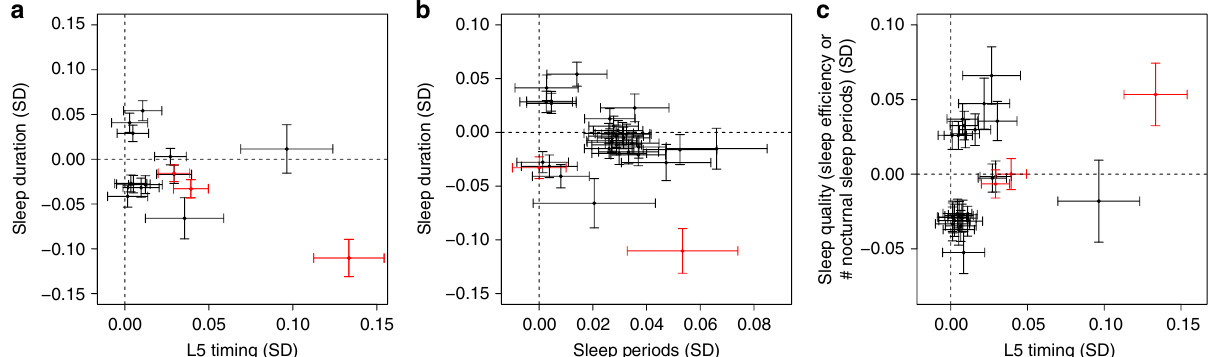
0.00 Fig. 2 Effects of restless legs syndrome-associated SNPs on derived sleep traits. Presented are the effect estimates for genetic variants associated with a either L5 timing or sleep duration, b either sleep duration or the number of nocturnal sleep episodes, and c either L5 timing or sleep quality (number of nocturnal sleep episodes or sleep ef fi ciency). Variants previously associated with restless legs syndrome are highlighted in red. Effect estimates represent standard deviations of the inverse-normal distribution of each trait. Error bars represent the 95% con fi dence intervals for each effect estimate NATURE COMMUNICATIONS| (2019) 10:1585